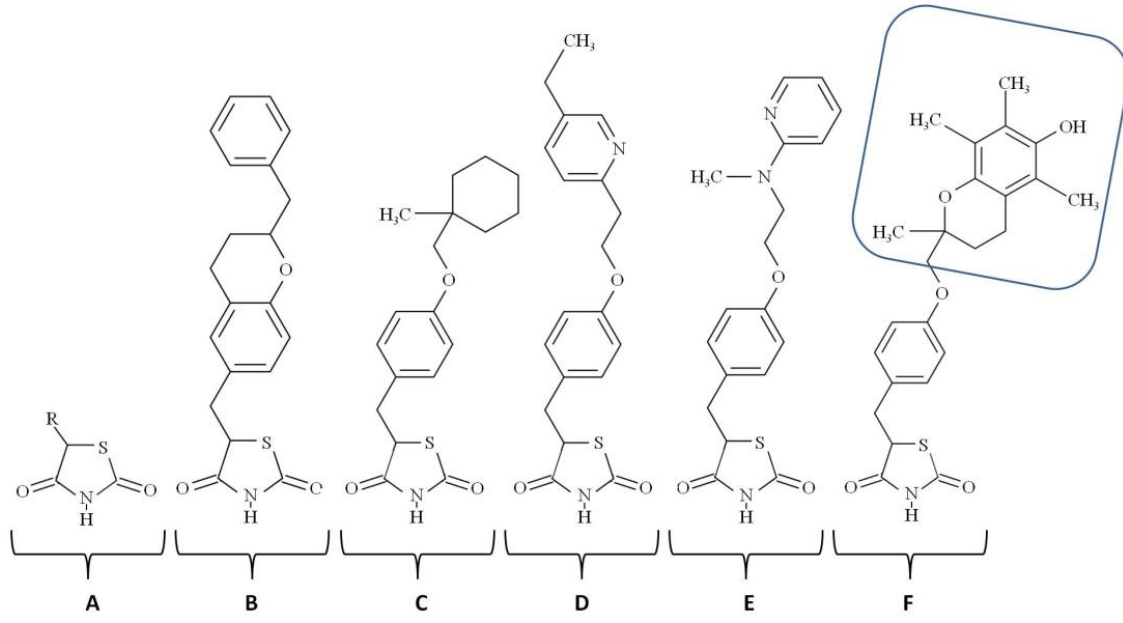
Figure 1. Chemical structures of the thiazolidinediones: A — thiazolidinedion; B — englitazone; C — ciglitazone; D — pioglitazone; E — rosiglitazone, F — troglitazone (the tocopherol group of troglitazone is shown inside the rounded blue rectangle).